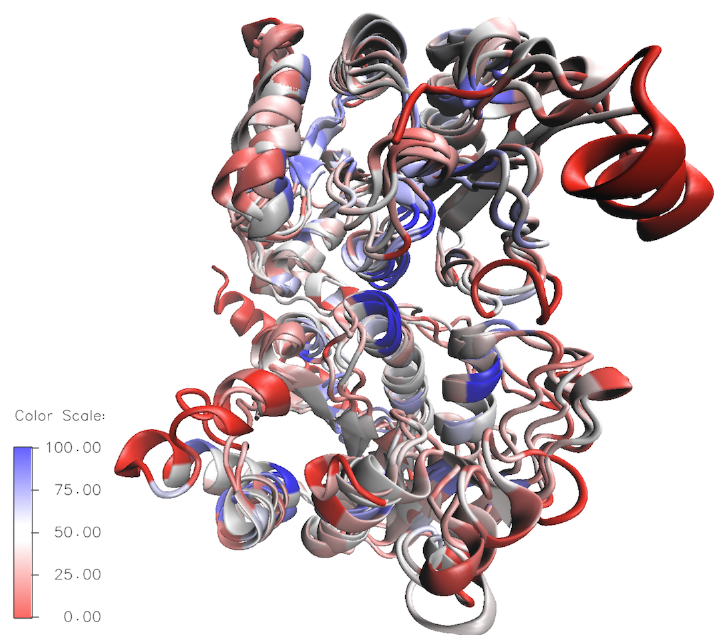
Figure 7. Overlay of Structurally aligned HepI–IV; residues are colored by sequence similarity [highly conserved (blue) non-conserved